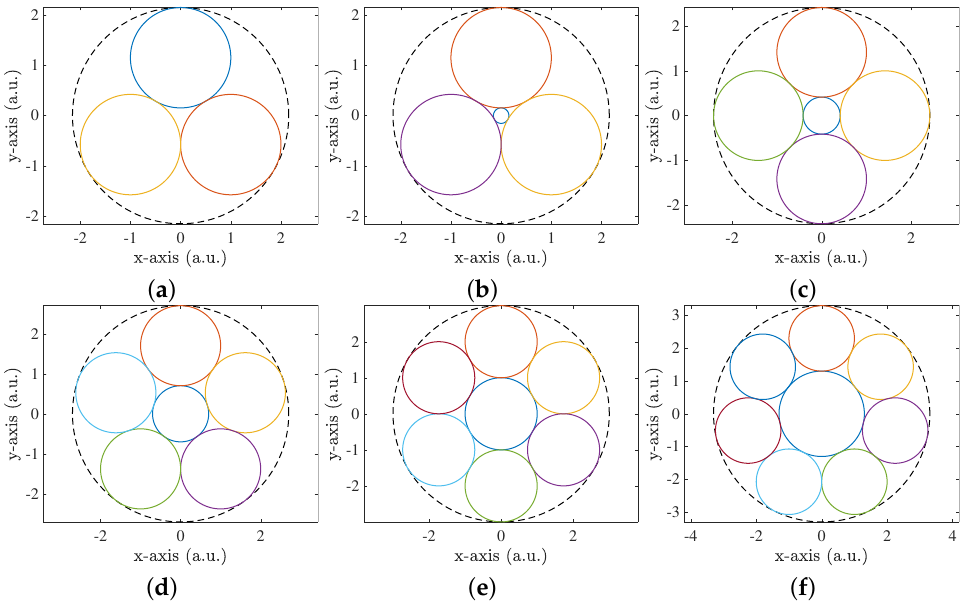
Figure 8. Scheme of N sensors given by the “circle packing in a circle” algorithm. ( a ) N = 3; ( b ) N = 4; ( c ) N = 5; ( d ) N = 6; ( e ) N = 7; ( f ) N =